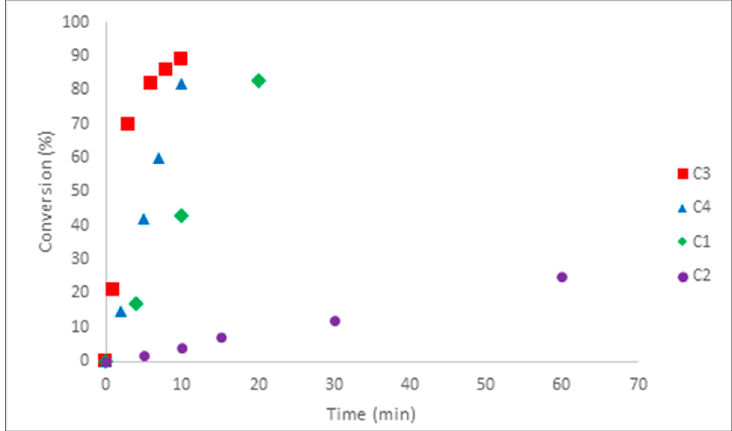
Figure 5. Monomer conversion (%) in function of time (min) for pre-catalysts C1 – C4 (Isoprene/Al i Bu 3 /[Ph 3 C][B(C 6 F 5 ) 4 ]/Fe = 5,000/3/1/1).